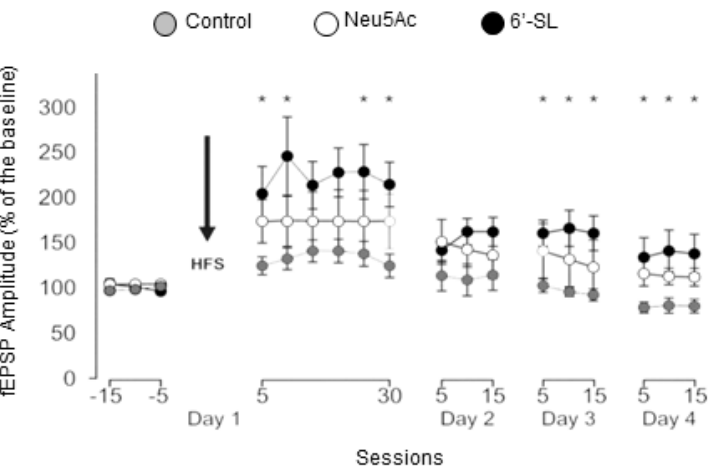
Figure 3. Experimentally-evoked LTP in the groups of animals at one year of age. Data collected from the three groups of animals before and after high-frequency stimulation (HFS) session (indicated by the downward arrow). The HFS was presented after 15 min of baseline recordings. LTP evolution was followed for up to four days. Statistical differences between groups were determined with a two-way repeated measure of the analysis of variance (ANOVA). The three groups of animals presented a significant ( p ≤ 0.05) LTP in relation with baseline values. In addition, field excitatory post-synaptic potential (fEPSP) values evoked after the HFS session were significantly larger (*, p ≤ 0.05) for the 6 ′ -SL group in comparison with values collected from controls. Data are represented as the mean ± SEM ( n = 10 animals/group). Neu5Ac, N-acetylneuraminic acid; 6 ′ -SL, 6 ′ -sialyllactose.